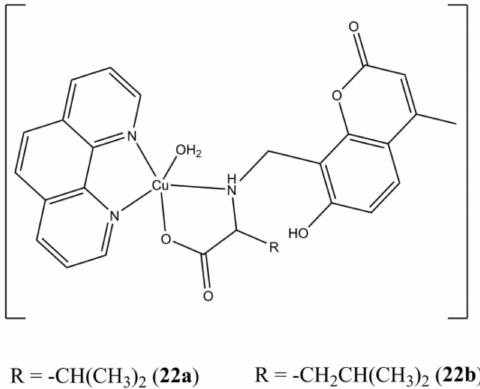
Figure 22. Structures of the [Cu(MCVH)(phen)(OH 2 )](ClO 4 ) ( a ) and [Cu(MCLH)(phen)(OH 2 )](ClO 4 ) ( b )